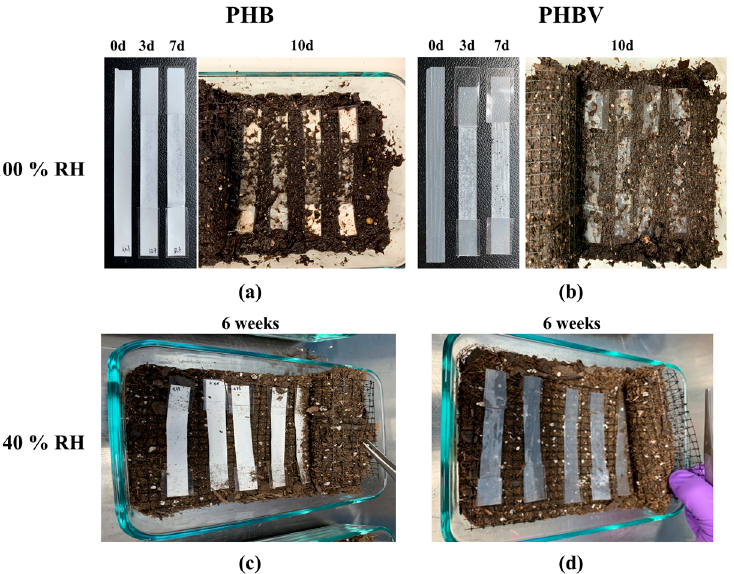
Figure 2. Soil degradation of ( a ) PHB and ( b ) PHBV aged in soil saturated with H 2 O (100% RH) for 0, 3, 7, and 10 days, and ( c ) PHB and ( d ) PHBV aged in soil kept at 40% RH for 6 weeks.